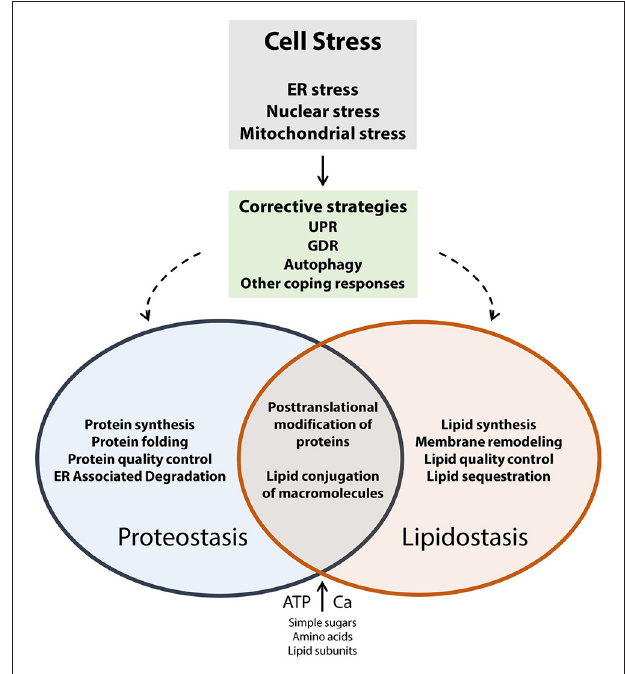
FIGURE 1 | Cell stress coping responses and the interplay between proteostasis and lipidostasis. Proteostasis refers to optimal protein biosynthesis and trafficking whereas lipidostasis pertains to optimal lipid biosynthesis, trafficking, and membrane assembly. Both of these processes rely on the availability of energy (ATP), and nutrients (such as Ca 2 + , sugars, amino acids, lipid subunits, nucleotides, other essential cofactors). When cells experience external or internal insults that result in the loss of control of nutrient and energy metabolism corrective strategies (UPR, GDR, autophagy, other coping responses) are activated to counteract and eliminate cell stress. The regulatory and metabolic pathways that operate to recover proteostasis and lipidostasis are interconnected, and support each other in preserving global cellular